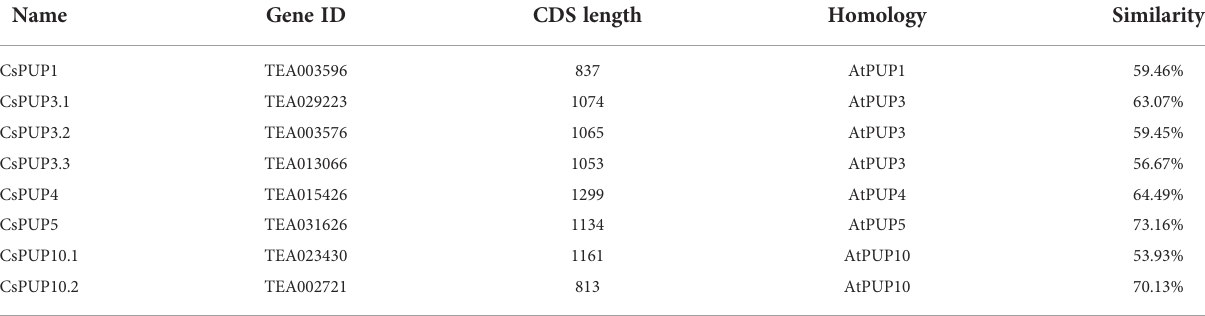
TABLE 1 Identi fi cation of PUPs in tea